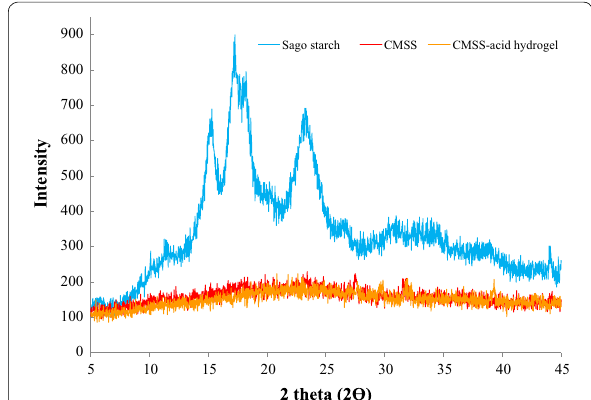
Fig. 9 XRD diffractogram of sago starch, CMSS and CMSS–acid hydrogel